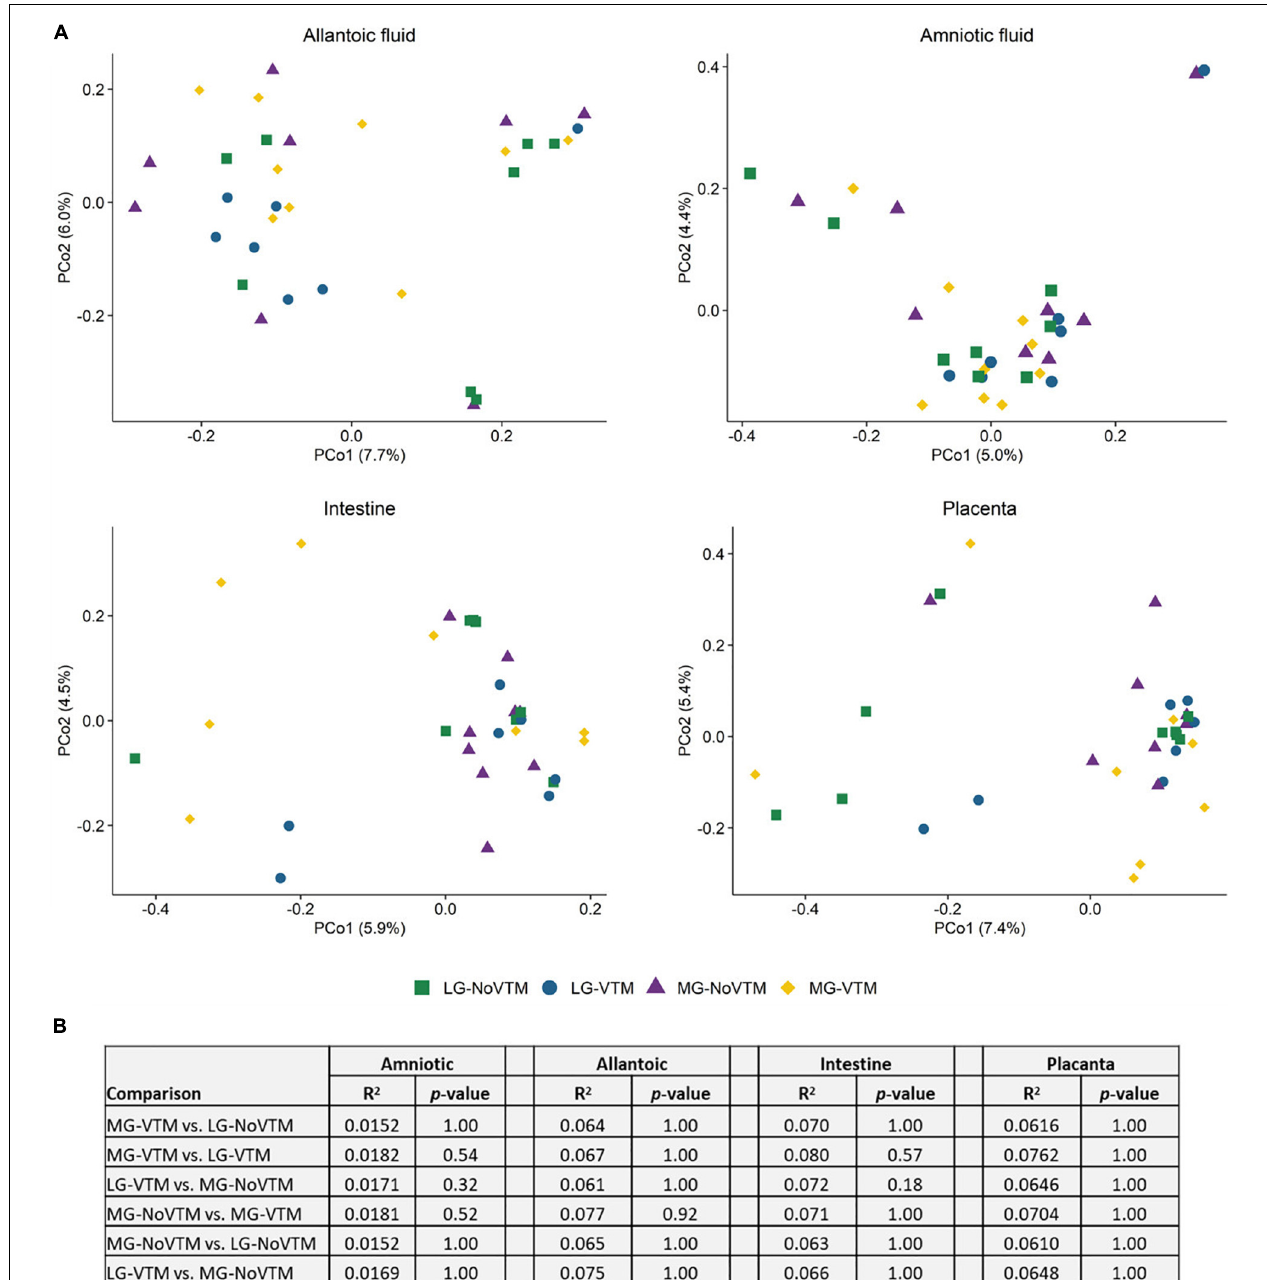
FIGURE 5 | The effects of rate of gain, and vitamin and mineral supplementation on beta diversity of the allantoic and amniotic fluid, and intestinal and placental microbiota in 83-day-old calf fetuses ( n = 33) (A) Principal coordinates analysis (PCoA) plot of the Bray-Curtis metric in amniotic and allantoic fluids, and intestinal and placental tissue samples obtained from 83-day-old calf fetuses. The percentages of variation explained by the PCoA are indicated on the axis; (B) The results summary of PERMANOVA analysis by treatment groups; The fetuses harvested from the following four groups of dams that either received diets containing no vitamin and mineral supplementation and targeted to moderate gain (MG-NoVTM); diet containing no vitamin and mineral supplementation and targeted to low gain (LG-NoVTM); diet containing vitamin and mineral supplementation and targeted to moderate gain (MG-VTM); diet containing vitamin and mineral supplementation and targeted to low gain